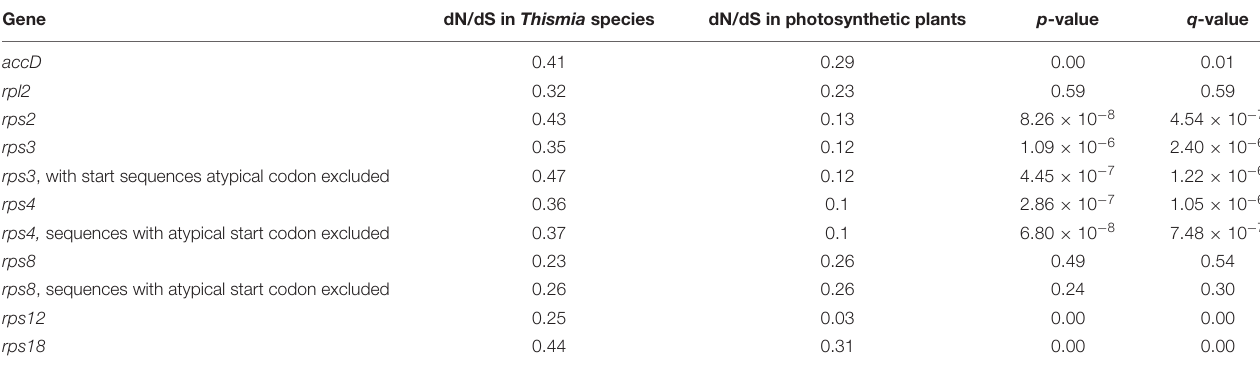
TABLE 2 | dN/dS values for species of Thismia and their photosynthetic relatives and p -value and q -value for the hypothesis of the difference of dN/dS values between photosynthetic and non-photosynthetic species. Gene dN/dS in Thismia species dN/dS in photosynthetic